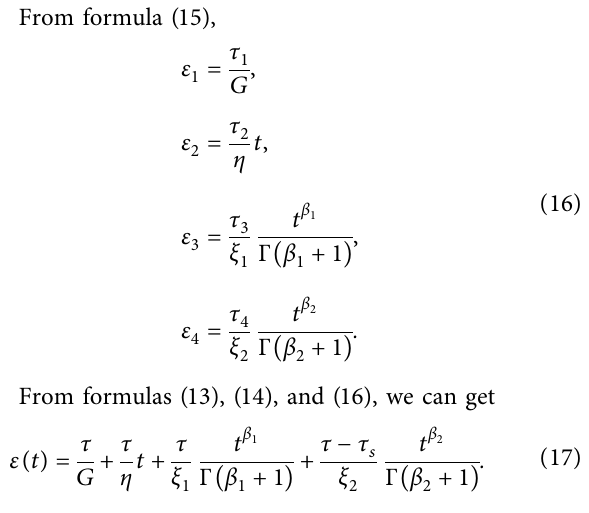
Figure 4: Shear creep test curve.